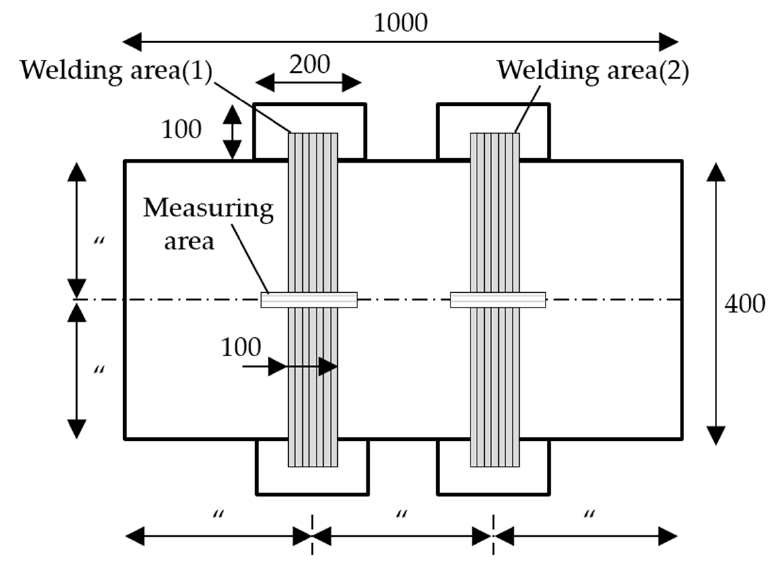
Figure 2. Schematic of welding specimen. Measurements are in mm.